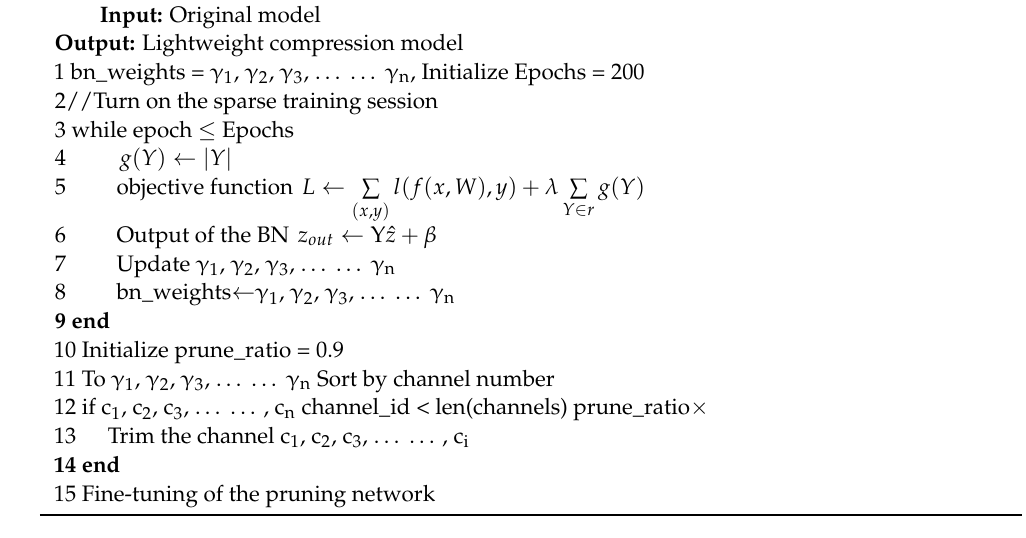
Algorithm 1 A channel pruning algorithm based on the scaling factor